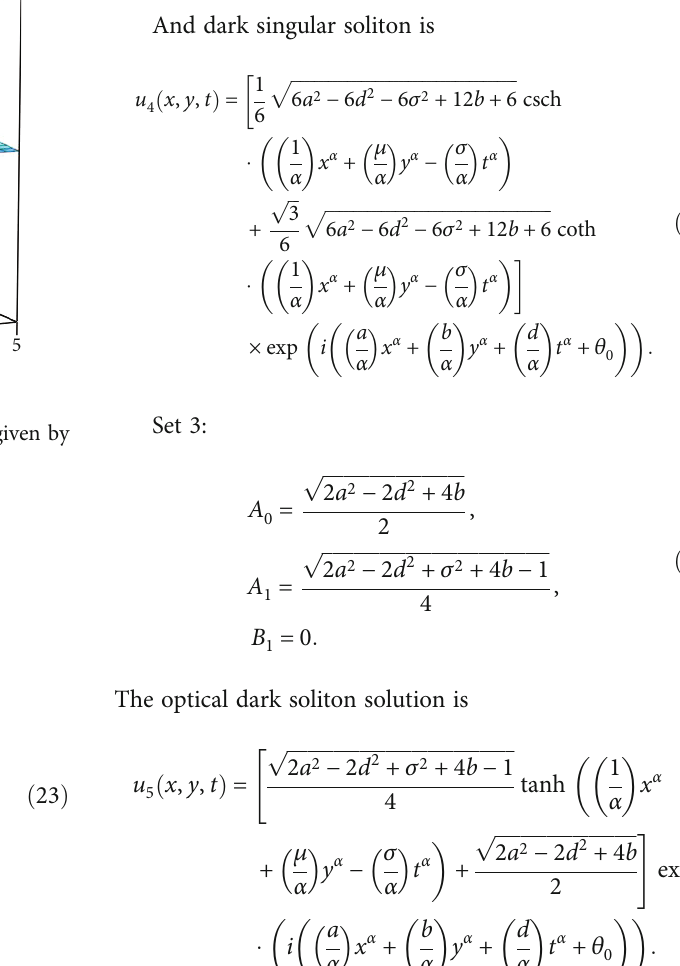
p ffiffiffiffiffiffiffiffiffiffiffiffiffiffiffiffiffiffiffiffiffiffiffiffiffiffiffiffi 2 a 2 − 2 d 2 + 4 b